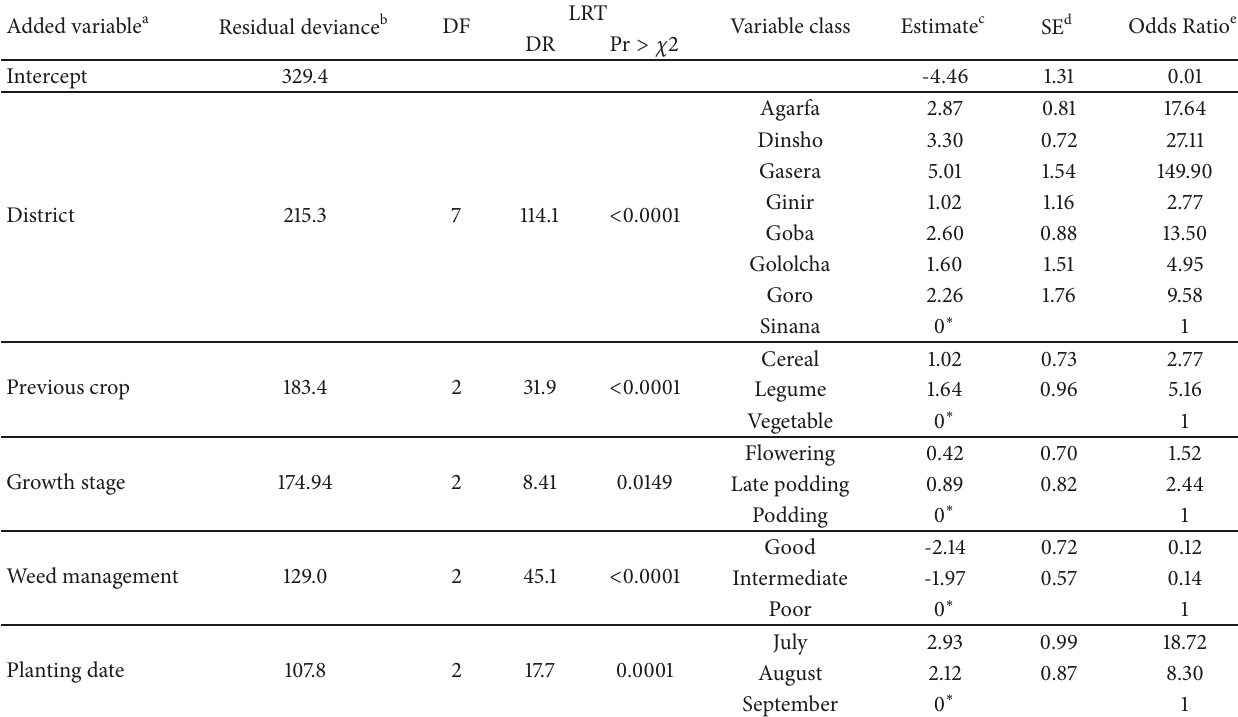
Table 9: Analysis of deviance,natural logarithms of odds ratio, and standard error of added variables in a reduced model analyzing faba bean rust percentage severity index